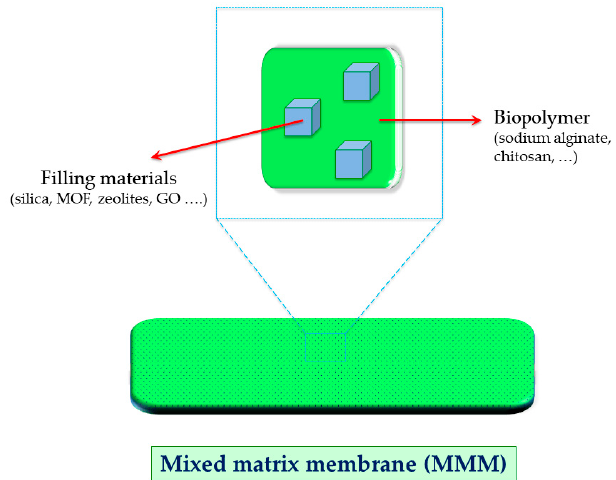
Figure 2. Representative scheme of a biopolymer-based mixed matrix membrane.